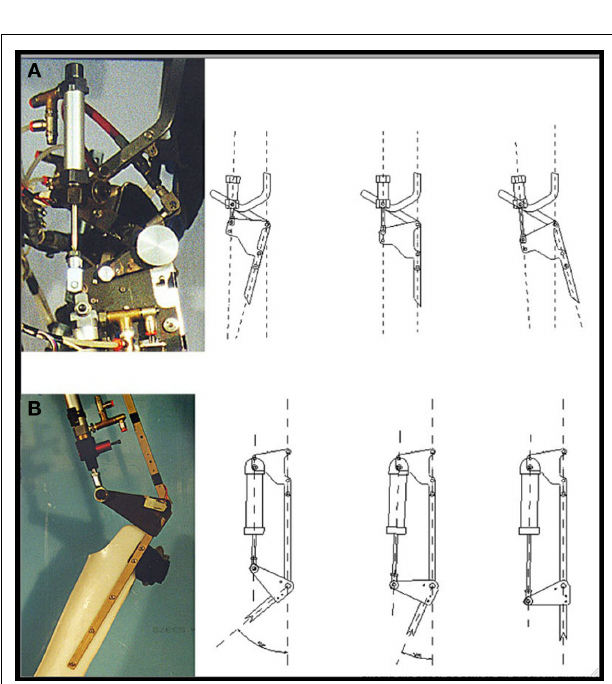
FIGURE 2 | Details of hip (A) and knee (B) actuation system. (Source, Li et al., 2008).